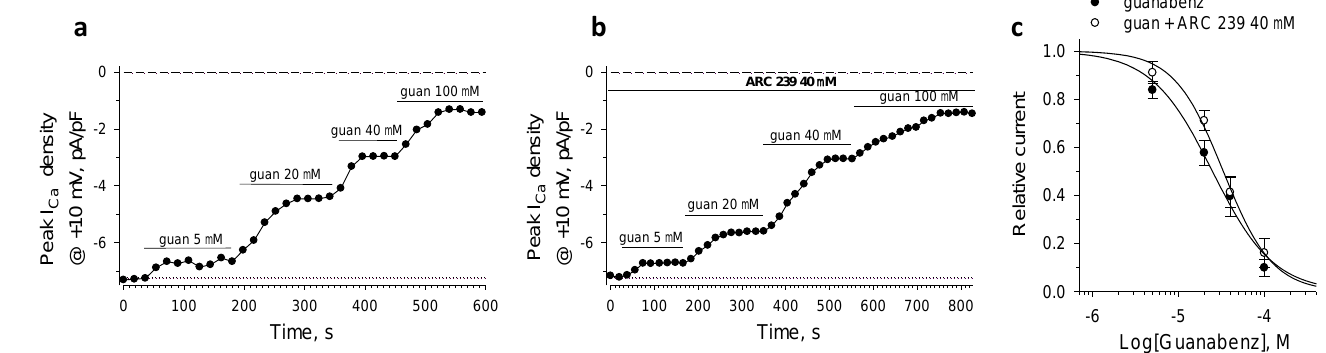
Figure 3. The effect of ARC 239, a specific antagonist of the α2B isoform, on the guanabenz -induced suppression of I CaL . ( a , b ) Representative time-courses of peak I CaL density values of guanabenz (guan)-induced suppression of I CaL in the absence and presence of the antagonist ARC 239. Horizontal bars denote the protocol of the drug applications. ( c ) ARC 239 induced a minor rightward shift of dose-dependent inhibition of I CaL at the lower concentrations of guanabenz.